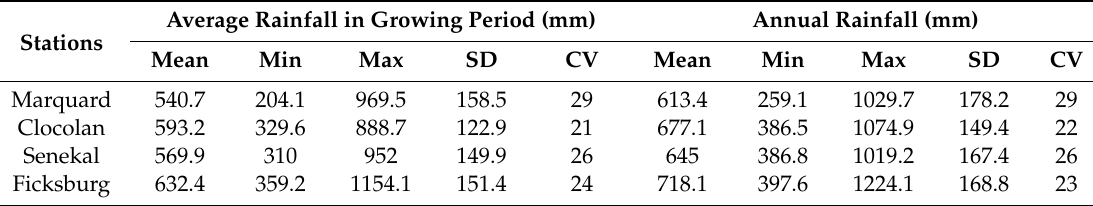
Table 3. Rainfall (mm) during the growing period October–April (mean, minimum, maximum, standard deviation and coe ffi cient of variation) in Setsoto Municipality (1985–2016).